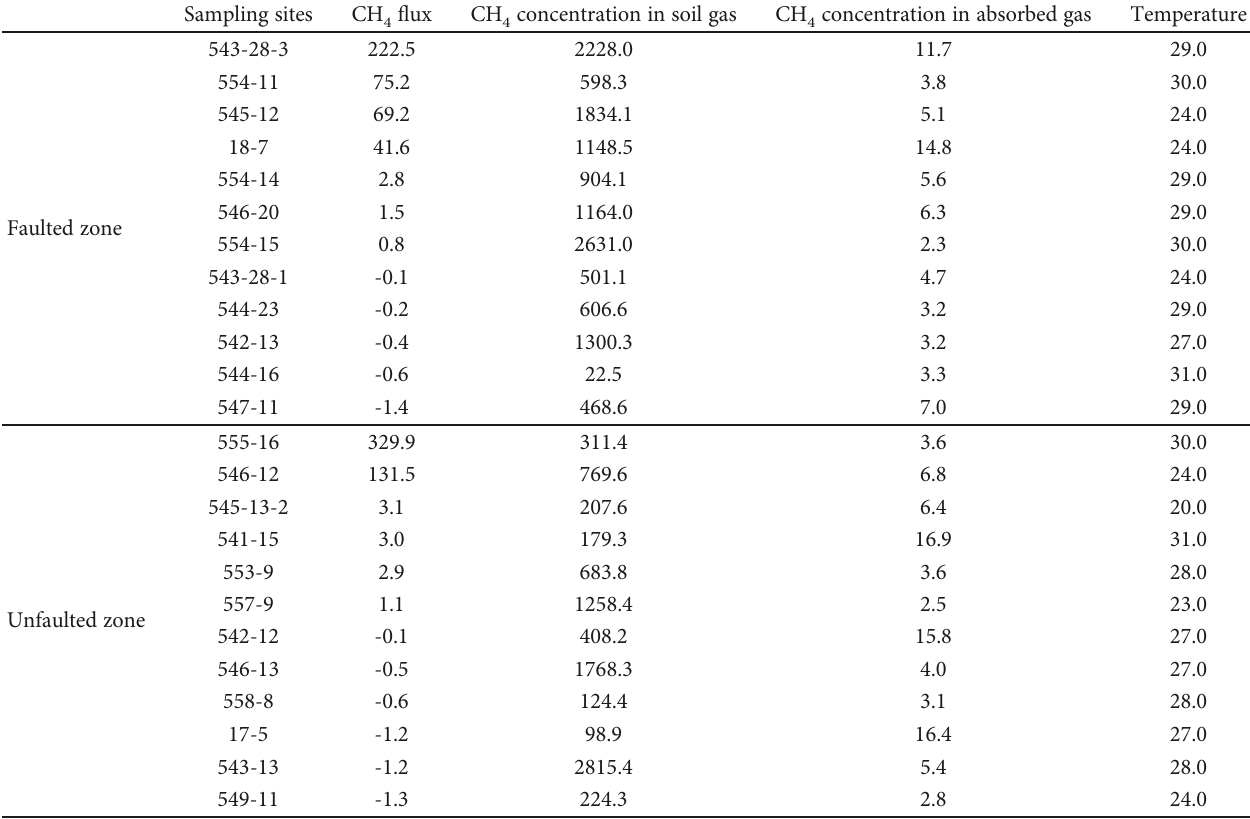
in fl ux, soil gas, and absorbed gas in Dawanqi oil fi eld. 4